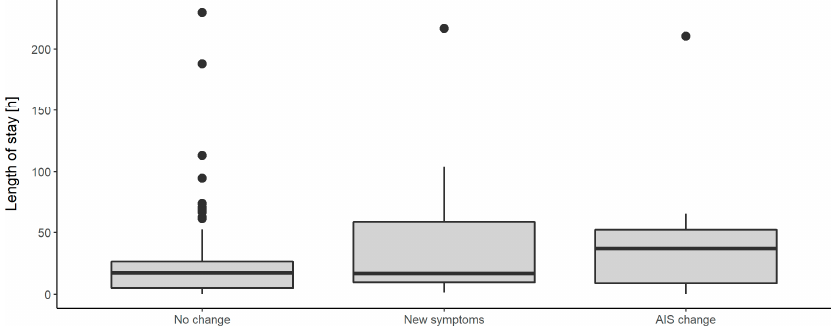
Figure 2. Distribution of length of stay (LOS) in correlation to the variables “No change“, “New symptoms“, and “AIS Change“. Dots represent outliers.